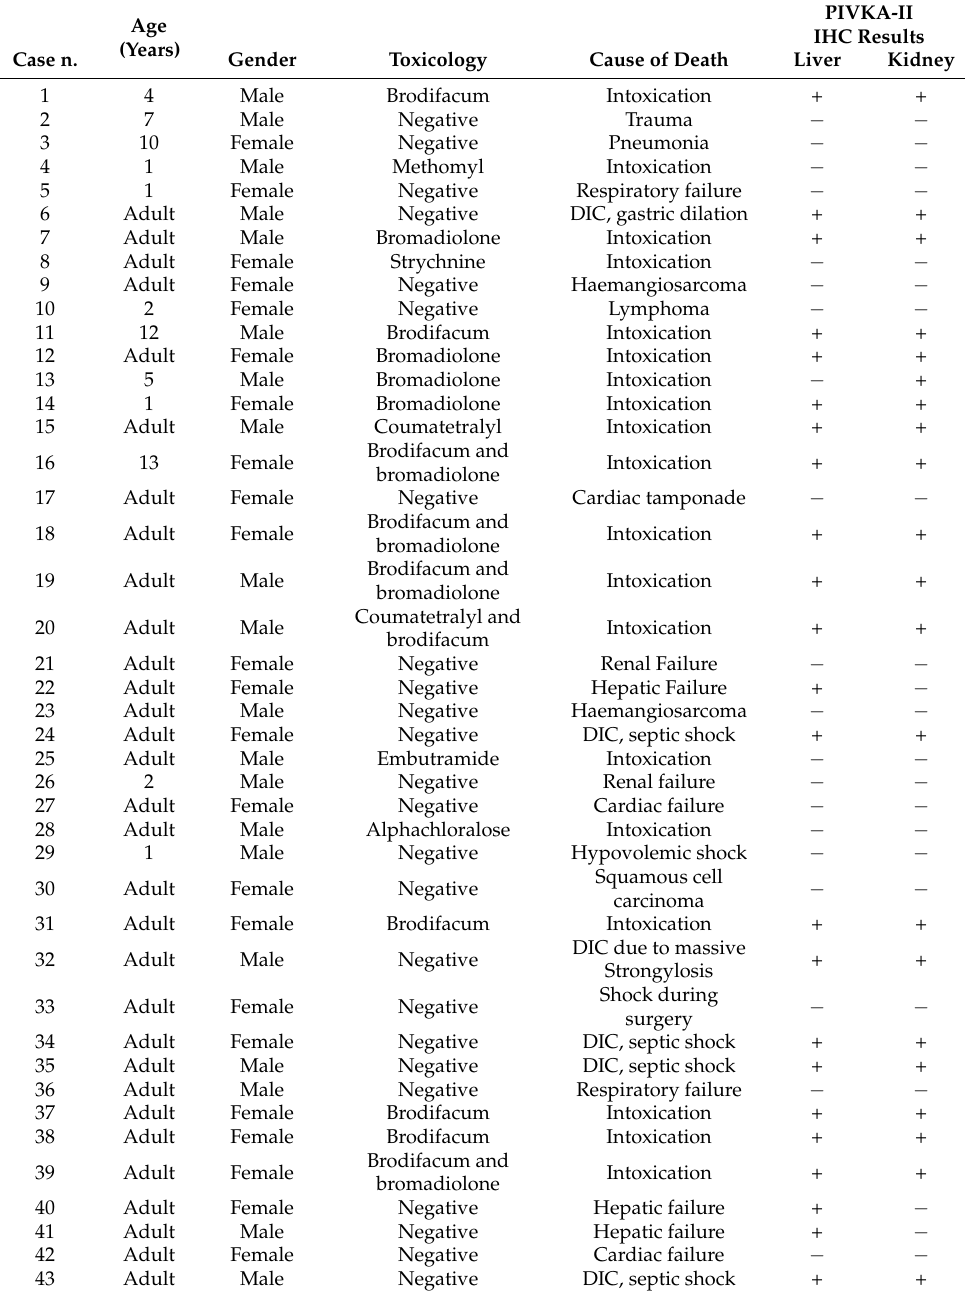
PIVKA-II IHC Results